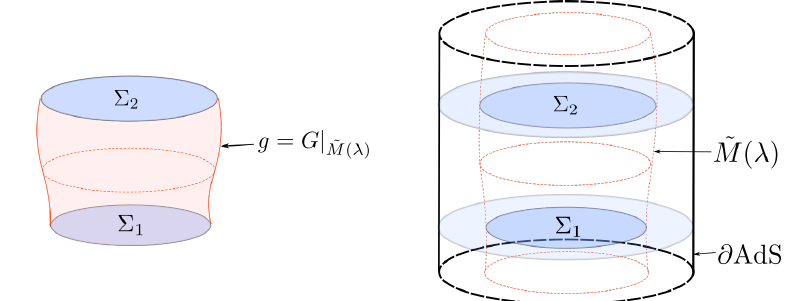
Figure 1: Coarse-grained vs fine-grained bulk path integrals. Left: A path integral representation of the transition amplitude between two compact manifolds Σ Σ with specified metrics. The gravitational path integral has Dirichlet boundary 2 conditions g . Right: Embedding in a larger UV complete theory of gravity in AdS.